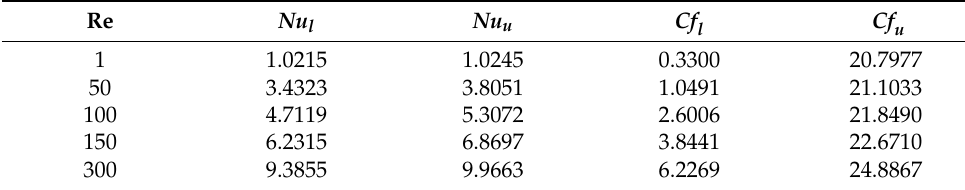
Table 5. Influence of Reynolds number (Re) on physical quantities.